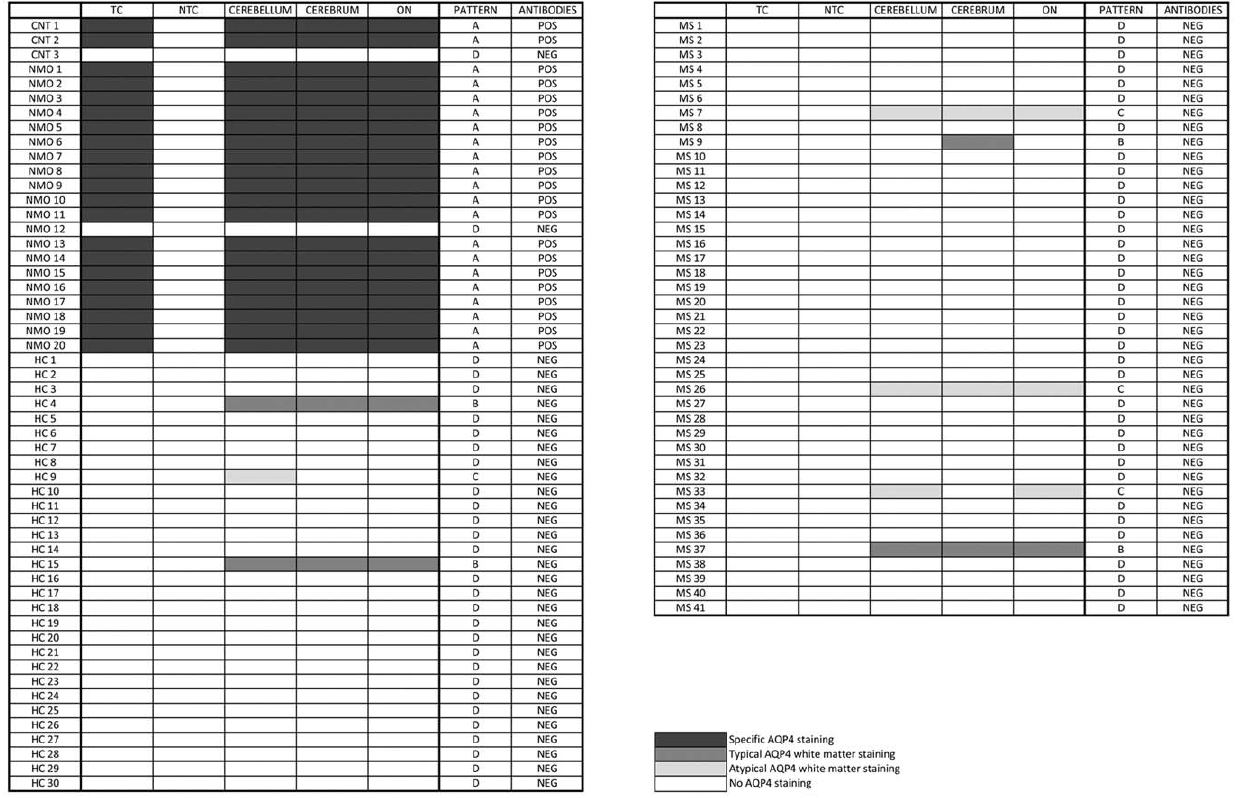
Figure 4. Differential distribution of IIF staining patterns in five diagnostic substrates following incubation with serum samples from patients with NMO or controls. The corresponding staining patterns (A, B, C, D; typical and atypical white matter staining), as defined in the results section, are indicated, together with the final evaluation of positivity or negativity for anti-AQP4 antibodies, and the healthy volunteers’ clinical status. NMO: neuromyelitis optica, MS: multiple sclerosis, HC: healthy controls, CNT 1: commercial goat polyclonal anti-human AQP4 IgG (H19, Santa Cruz Biotechnology), CNT 2: human anti-AQP4 positive serum provided by the manufacturer, CNT 3: human anti-AQP4 negative serum provided by the manufacturer, TC=transfected cells, NTC=non-transfected cells, ON=optic